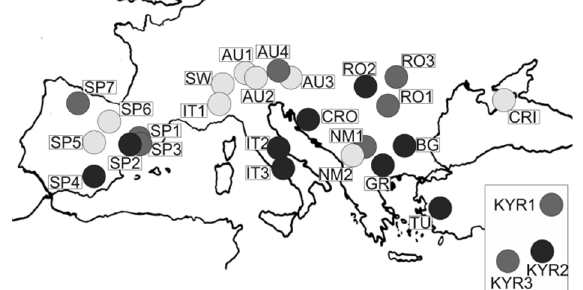
Figure 1. Localization of the J. sabina populations. Acronyms as in Table 1. Symbols mean classes of the length of cone (CL) of populations. Light grey CL ≤ 6.00 mm. Dark grey 6.00 < CL ≤ 6.50 mm Black CL > 6.50 mm.